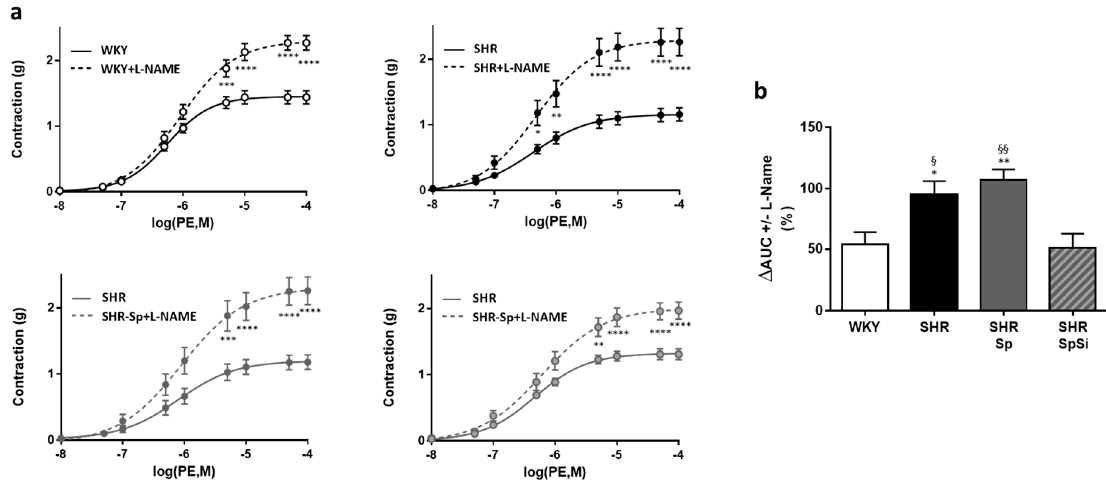
Figure 5. Impact of L-NAME on PE-induced contraction. ( a ) Cumulative dose-response curves to PE were performed in absence (plain lines) and in presence of 10 µM L-NAME (dotted lines). Data are expressed as mean ± s.e.m ( n = 15). **** p < 0.0001, *** p < 0.001, ** p < 0.01, * p < 0.05, PE vs . L-NAME